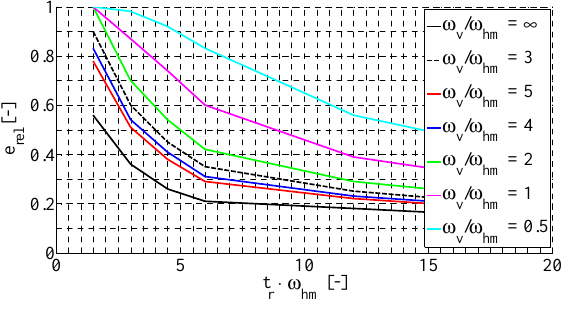
Figure 9: Relative error at the end of the ramp.